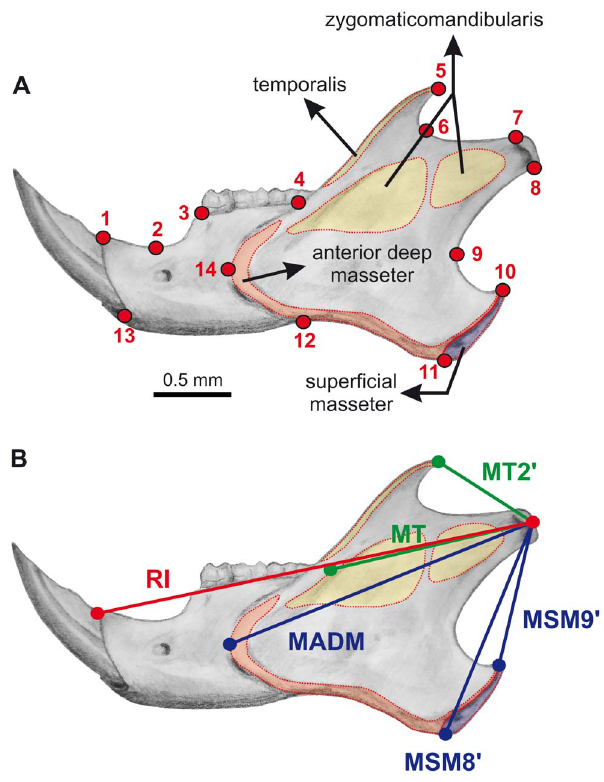
Figure 1. Mandible Sciurus vulgaris in lateral view showing landmarks, insertion areas of the masticatory muscles and muscle moment arms. a) Landmarks used in this study: (1) antero- dorsal border of the incisive alveolus; (2) most concave point of the diastema; (3) anterior alveolus of the lower premolar; (4) base of the coronoid process; (5) tip of the coronoid process; (6) most concave point of the incisura mandibulare; (7) anterior edge of the articular surface of the condyle; (8) posterior edge of the articular surface of the condyle; (9) most anterior point on the curve of the posterior edge of the mandible; (10) posterior tip of the angular process; (11) most ventral point of the angular process; (12) most dorsal point on the ventral border of the ramus; (13) antero-ventral border of the incisive alveolus; (14) anterior edge of the masseteric ridge. b) Muscle moment arms and resistance arm for the incisor. MSM9 9 = moment arm of the most dorsally inserting fibers of the superficial masseter; MSM8 9 = moment arm of the most ventral fibers of the superficial masseter; MADM = moment arm of the most anterior fibers o the anterior deep masseter; MT = moment arm of the most ventral fibers of the temporalis; MT2 9 = moment arm of the most dorsal fiber of the temporalis; RI = resistance arm of the incisor. See text for